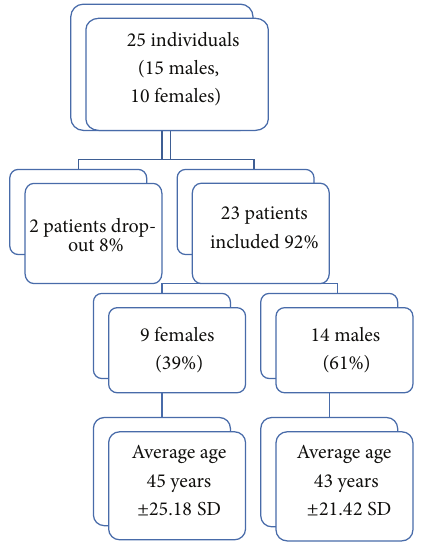
Figure 1: Stratification of the sample by age and